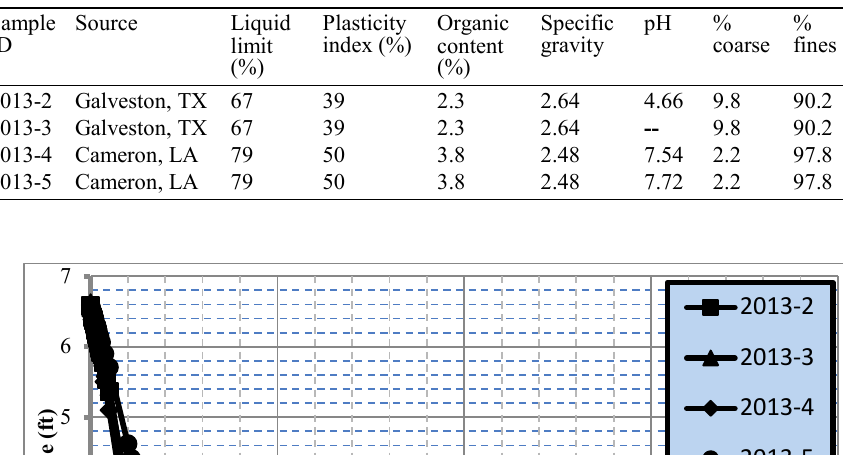
Table 1 Geotechnical properties of dredged slurry